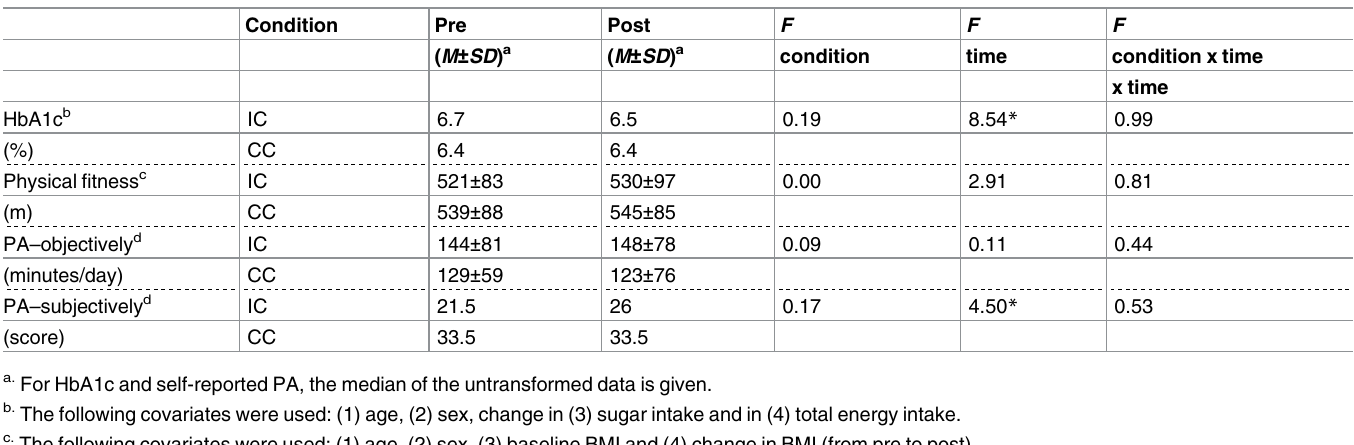
Table 4. Short-term effects–with covariates.